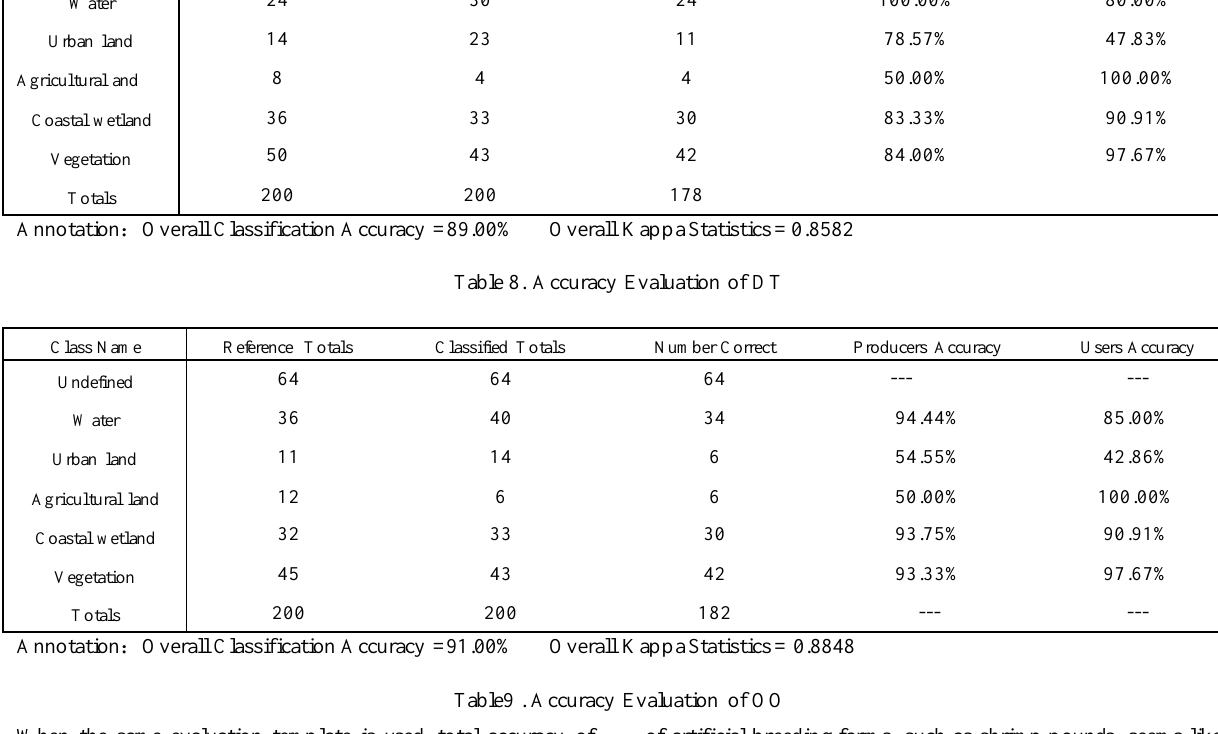
Table9 . Accuracy Evaluation of